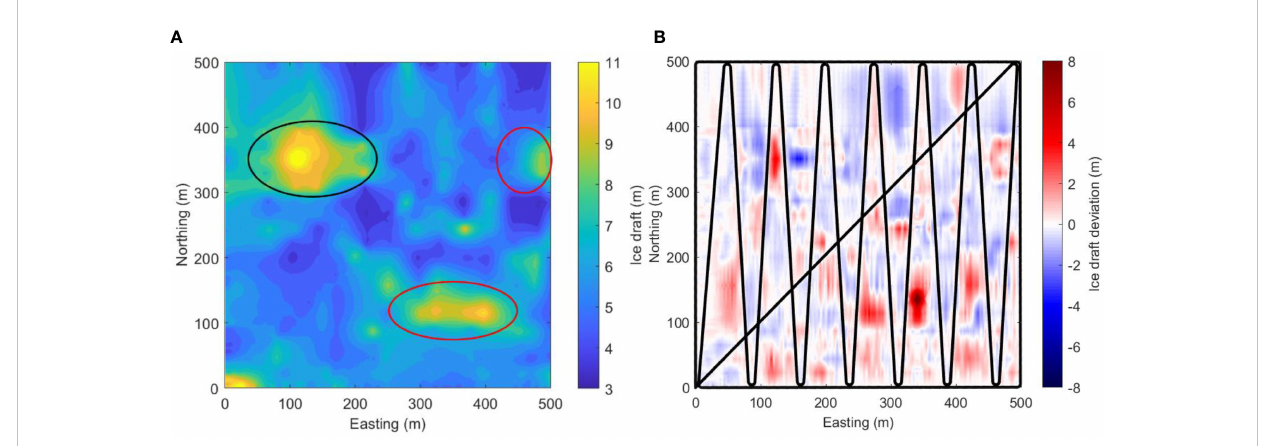
FIGURE 12 Reconstruction results by Kriging interpolation with fi xed trajectory (Red and black ellipses indicate the area for performance comparison). (A) Reconstructed ice draft map. (B) Deviation error between reconstructed and actual ice